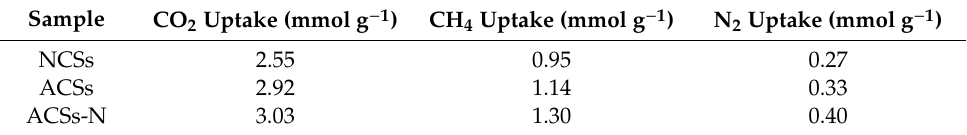
Table 2. Summary of the gas capacities of the NCSs, ASCs, and ACSs-N at 25 °C and 1 bar. Sample